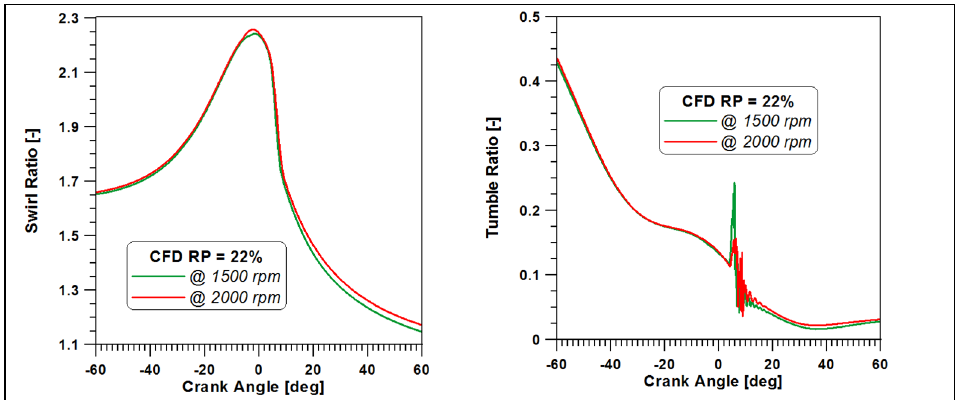
Figure 2. Comparison of swirl and tumble ratios for two different engine